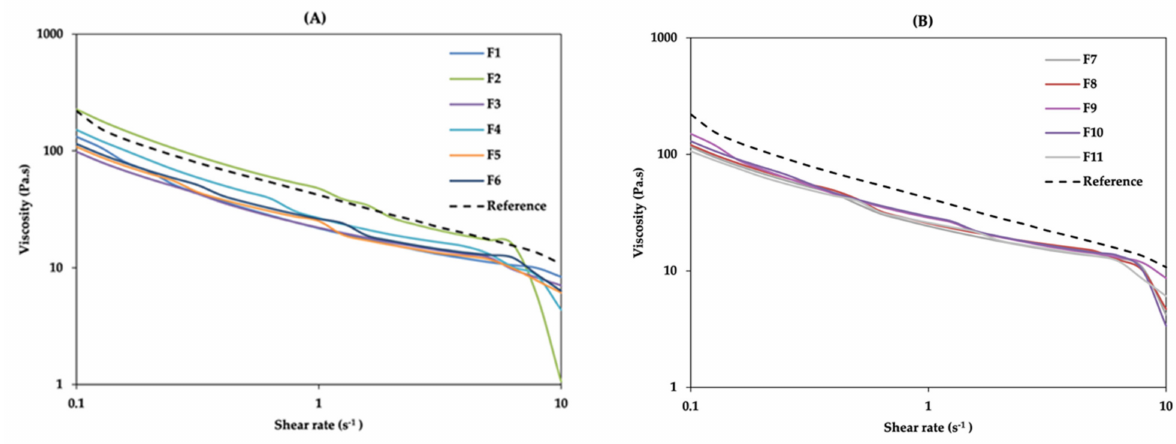
Figure 2. Effect of independent variables on cream viscosity: ( A ) F1–F6 and RF; ( B ) F7–F11 and RF (reference formulation). The results shown are means, n =